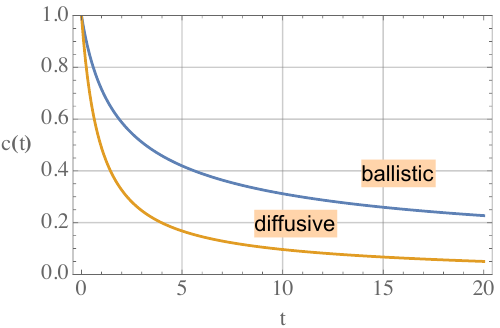
Figure 11: The time evolution of the ballistic and diffusive “occupation numbers” ( t ) and c ( t ) from equations (37) and (38). c ballistic diffusive Concluding, the time evolution of the localized perturbation is again driven by the ballistic propagation with diffusion playing a secondary role. Moreover, the modes with diffusive dy- namics decay faster. Despite this, there is a region in time in which the dynamics is diffusive, in the sense that the spatial variance of expectation values of local conserved charges grows linearly in time. This is caused by an interplay of the ballistic propagation, which mixes quasi- particles in the real space, and diffusive propagation, which mixes modes in the rapidities